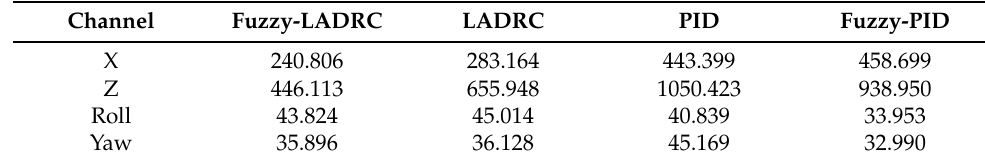
Table 5. Rise time t r (ms) of tracking step signal.